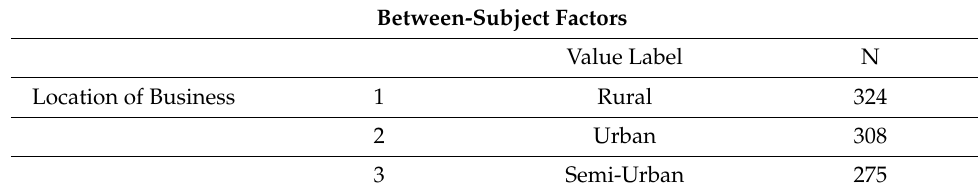
Table 6. Subject factors and equality of covariance matrices.